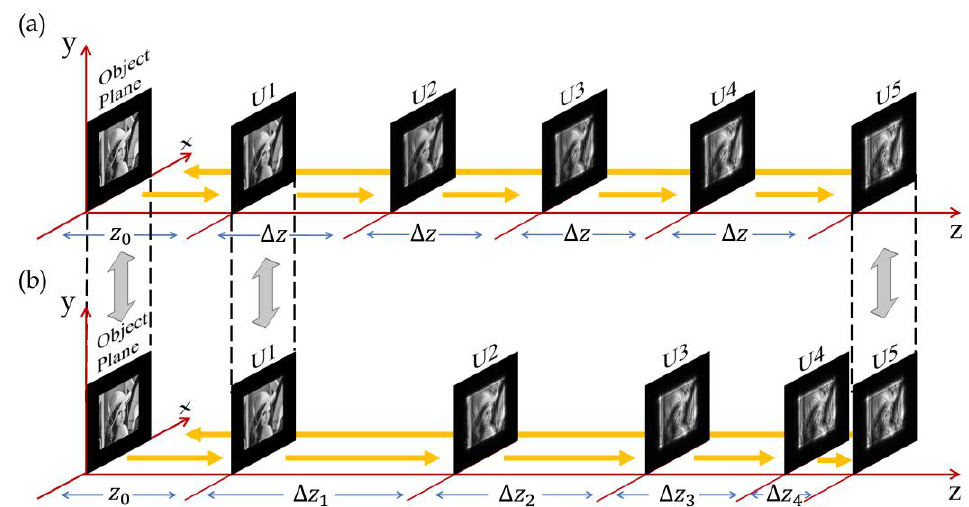
Figure 1. Schematic diagram of multi-distance phase retrieval: ( a ) SBMIR method; ( b ) Our proposed method.